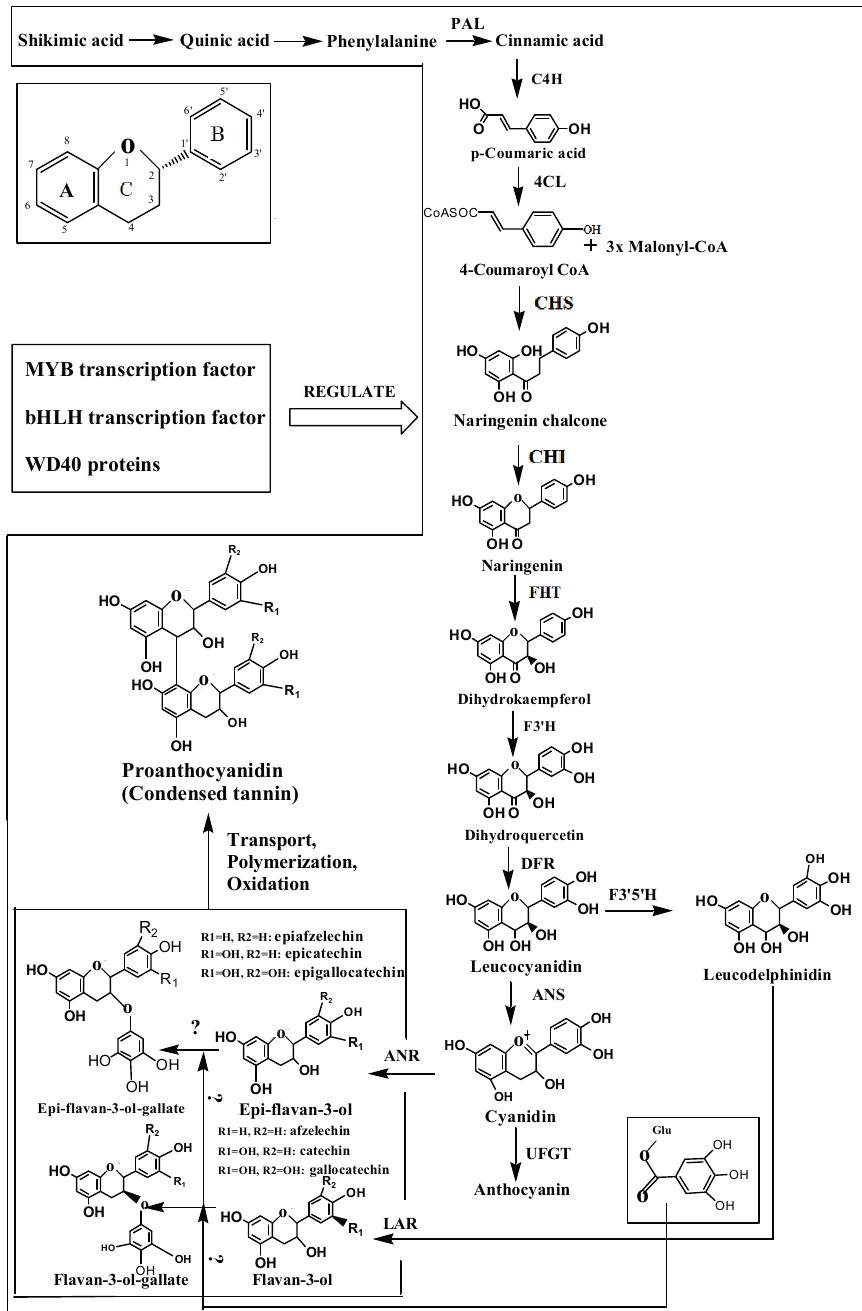
Figure 1. Tannin biosynthesis